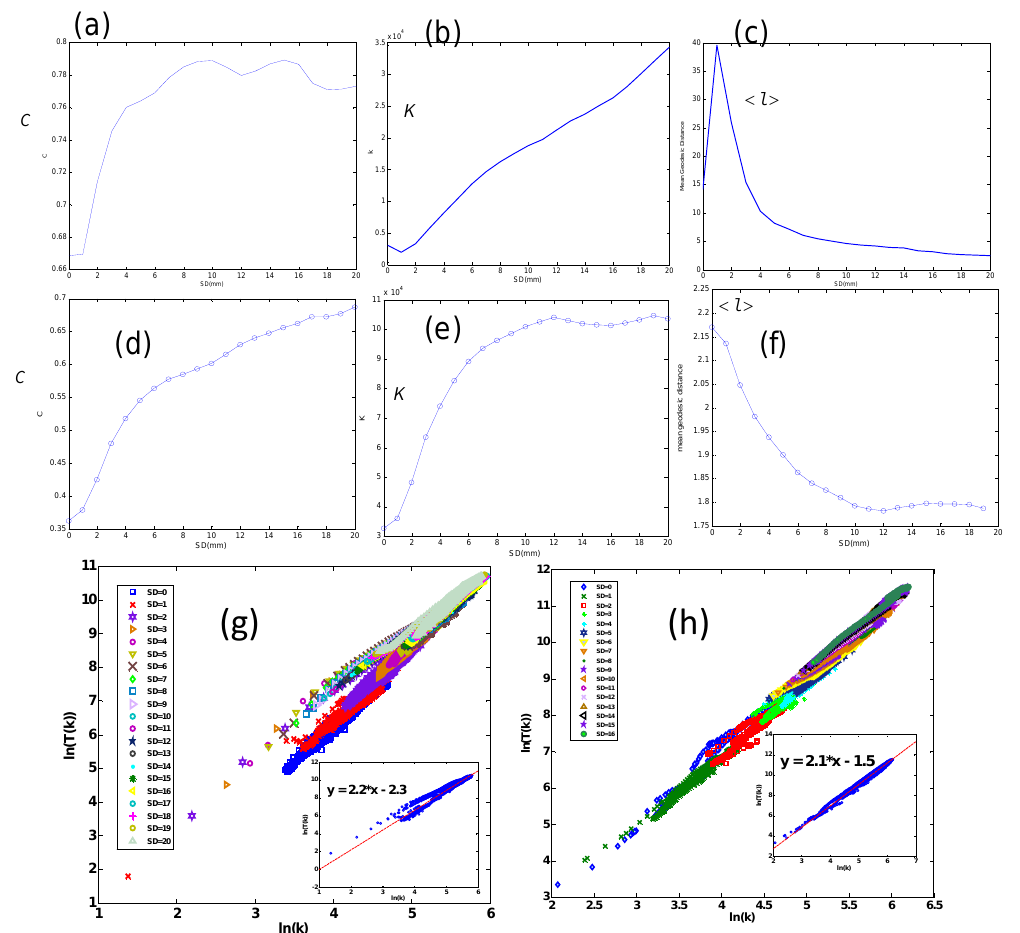
Fig. 2. Characteristics of the friction-networks in parallel profiles-networks to shear direction ( a – c ): (a) clustering coefficient-Shear Dis- placement (SD in mm); (b) number of edges-SD ; (c) average path length-SD; in transverse profiles-networks to shear direction ( d – f ); (g) X-profiles :scaling of triangles ( T (k) – i.e. loops) with node’s degree( k) as a power law with β ≈ 2 . 2 (inset shows the best fit linear line to collapsed data set in natural logarithmic scale). Also, We confirmed for real-time contact measures there is such universal power law (Ghaffari et al., 2011b); (h) Y-profiles (parallel to shear) a nearly same scaling with β ≈ 2 .